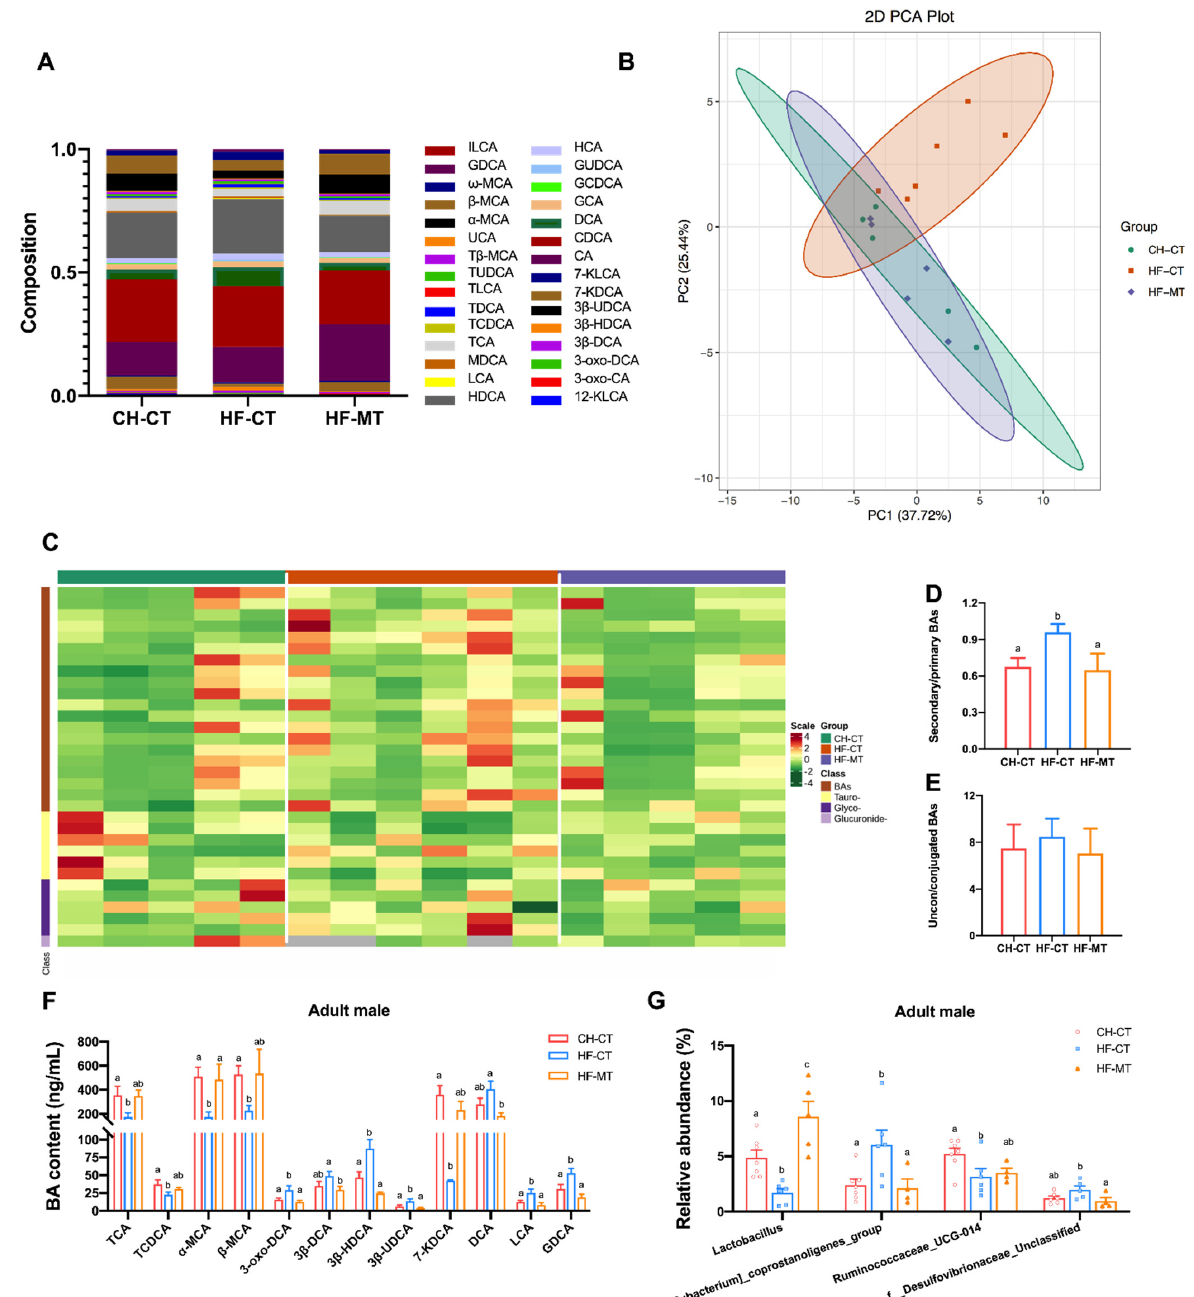
Figure 7. Maternal metformin treatment improves maternal high-fat diet-induced microbial bile acid dysmetabolism in adult male offspring: ( A ) BA pool composition in plasma; ( B ) principal component analysis (PCA) plot showing the plasma bile acid (BA) profiles of three experimental groups; ( C ) hierarchical cluster analysis (HCA) plot discriminating the plasma BA profiles of different groups; ( D , E ) ratios of secondary/primary and unconjugated/conjugated BAs in plasma; ( F ) significantly altered plasma BAs of three experimental groups; ( G ) relative abundance of the significantly altered gut bacteria at genus levels in fecal contents from the three groups. Data are presented as the mean ± SEM ( D – G ). CH-CT, n = 5–7; HF-CT, n = 5–6; HF-MT, n = 4–5. Statistical significance was determined using one-way ANOVA with Tukey’s post hoc tests. Groups with different superscript letters differ from each other at p < 0.05 level. (Abbreviations for the subtypes of BAs: I-iso; G-glyco; T-tauro; M-murine; H-hyo; K-keto;